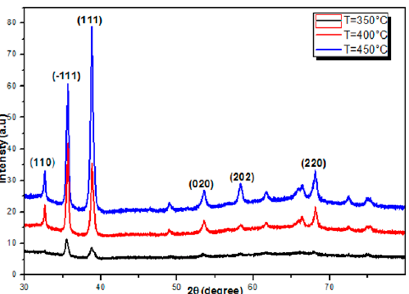
Figure 1. X-ray diffraction patterns of CuO thin films deposited at various substrate temperatures.